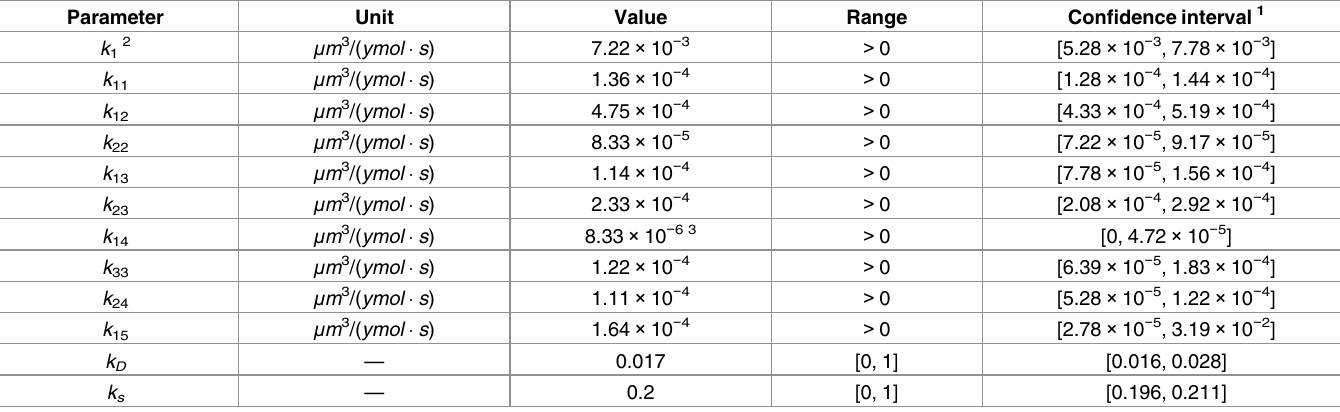
Table 4. Some parameter values for WT Gag optimized by the Tikhonov regularization method with data from [10]. Parameter